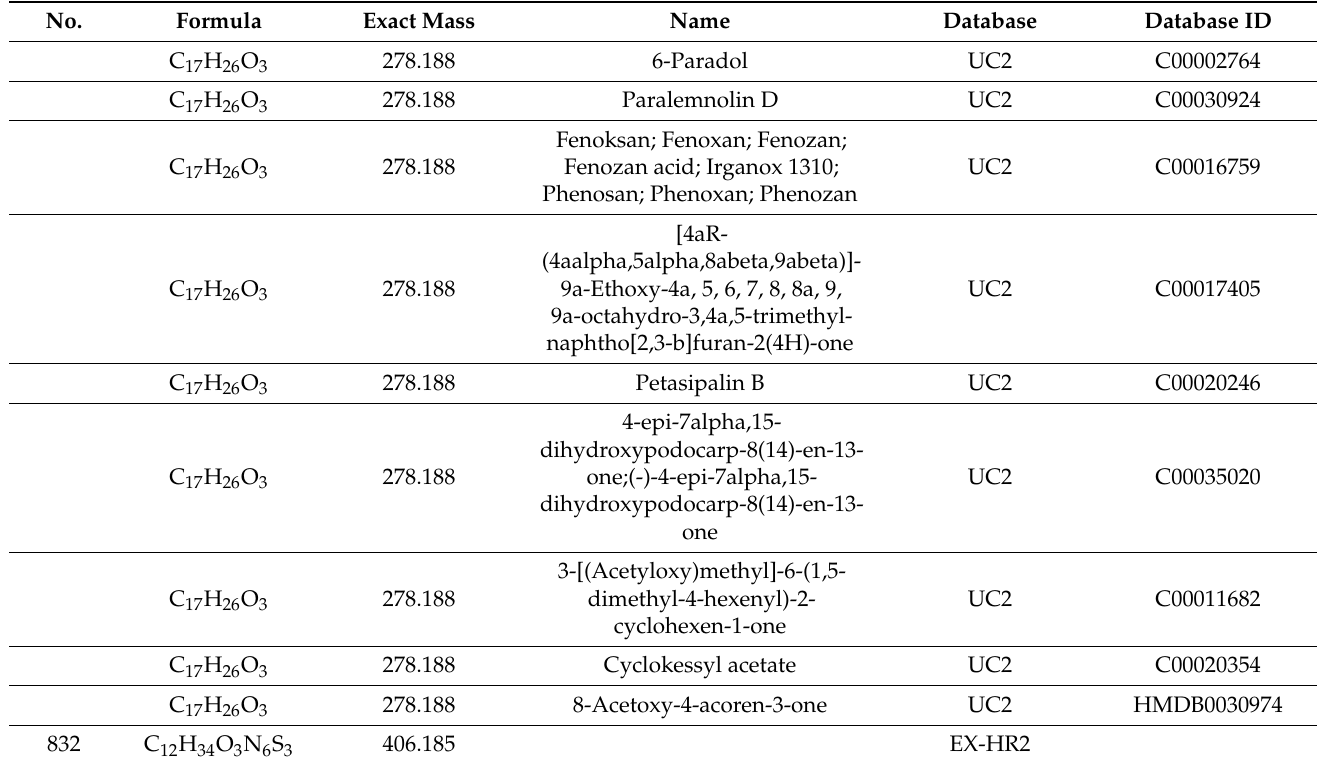
growth. Table S1: Genotypes of B. subtilis genome deletion mutants. Table S2: B. subtilis single gene deletion mutants used in this study. Table S3: Intensities of detected peaks in the MV fraction of C. thermocellum by LC-MS/MS. Table S4: Intensities of the detected peaks in cell-free B. subtilis trpC2 broth by LC-MS/MS. Table S5: Structures of constituents detected by LC-MS/MS in this